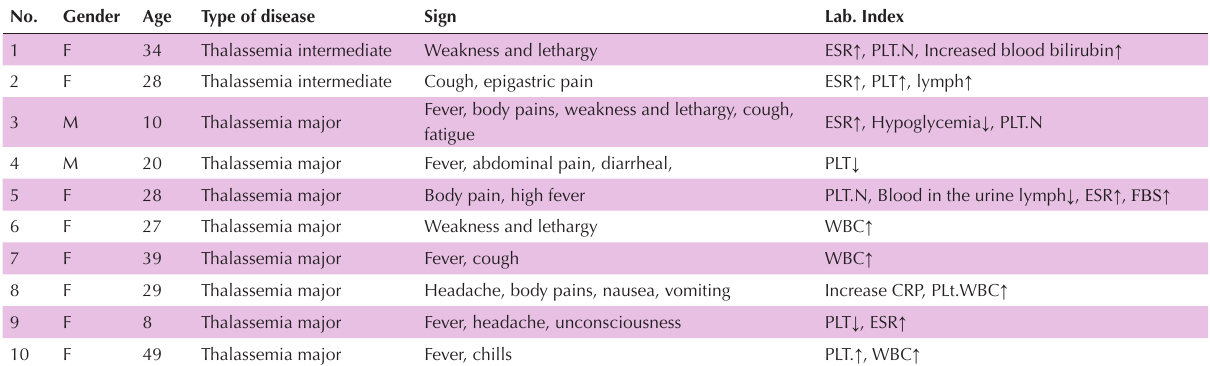
Table 1. Information of thalassemia patients with COVID-19 No. Gender